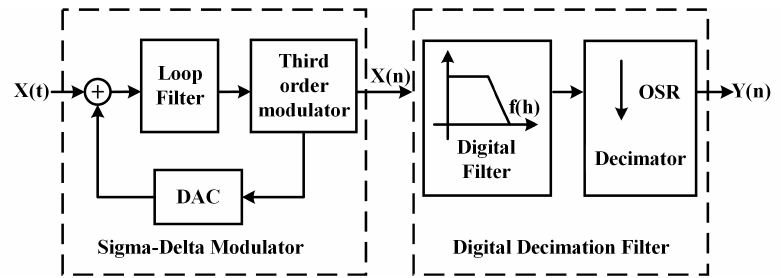
Figure 1. Block diagram of the Sigma-Delta